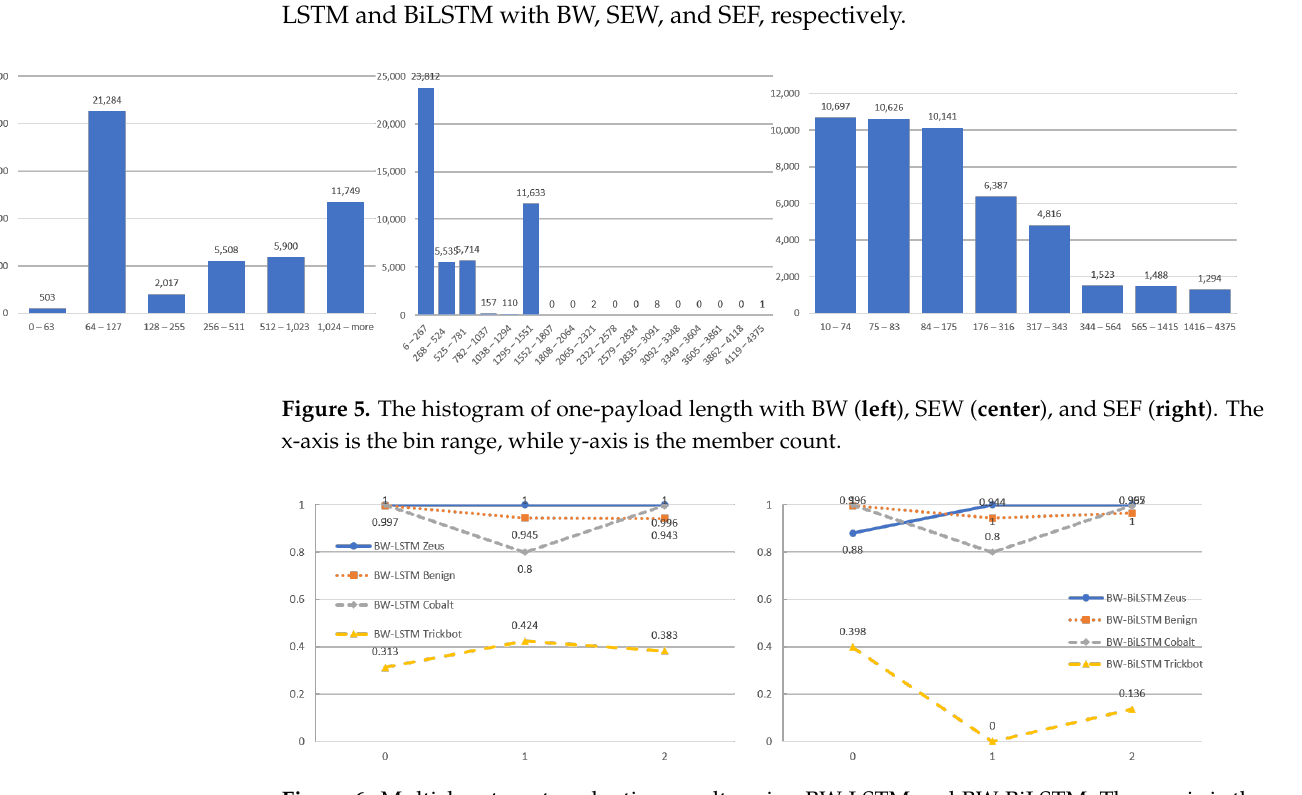
Figure 6. Multiclass target evaluation results using BW-LSTM and BW-BiLSTM. The x-axis is the payload from zero (with no binning), one, and two or more, while the y-axis is the F1 score.